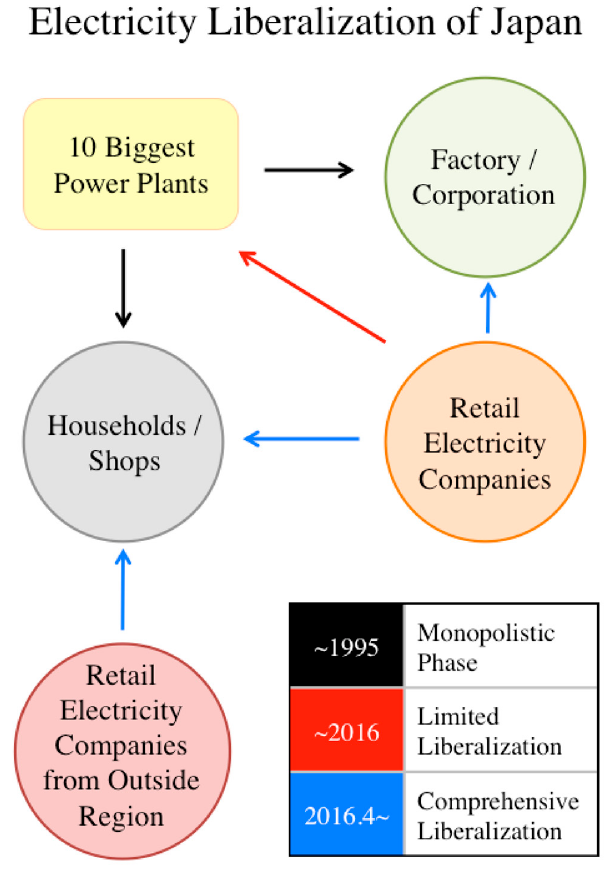
Figure 2. The gradual steps of electricity liberalization in Japan.